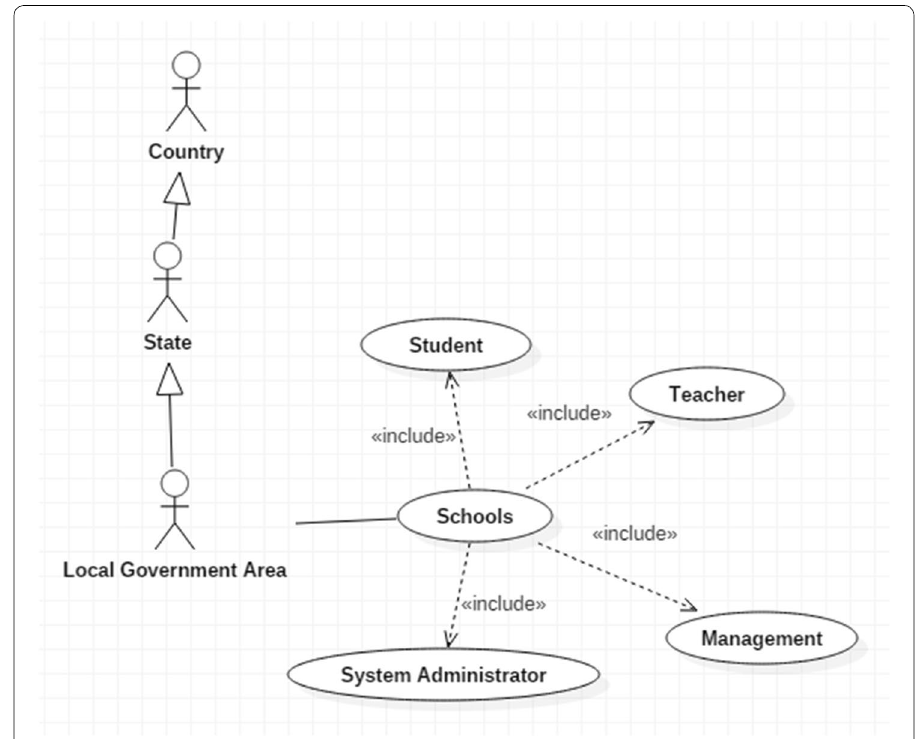
Fig. 9 Entity-Case diagram of the collocation data model of